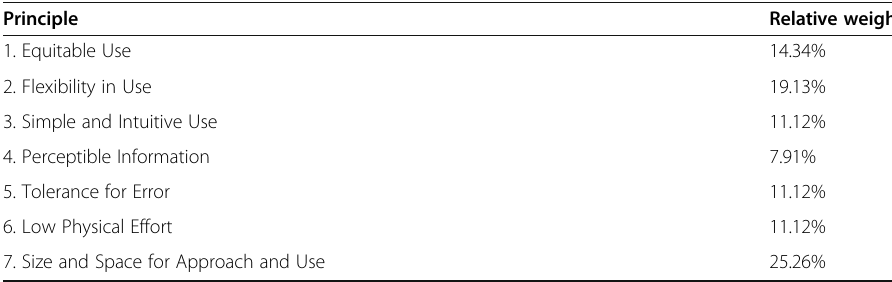
Table 1 Relative weights of the 7 UD principles [17]